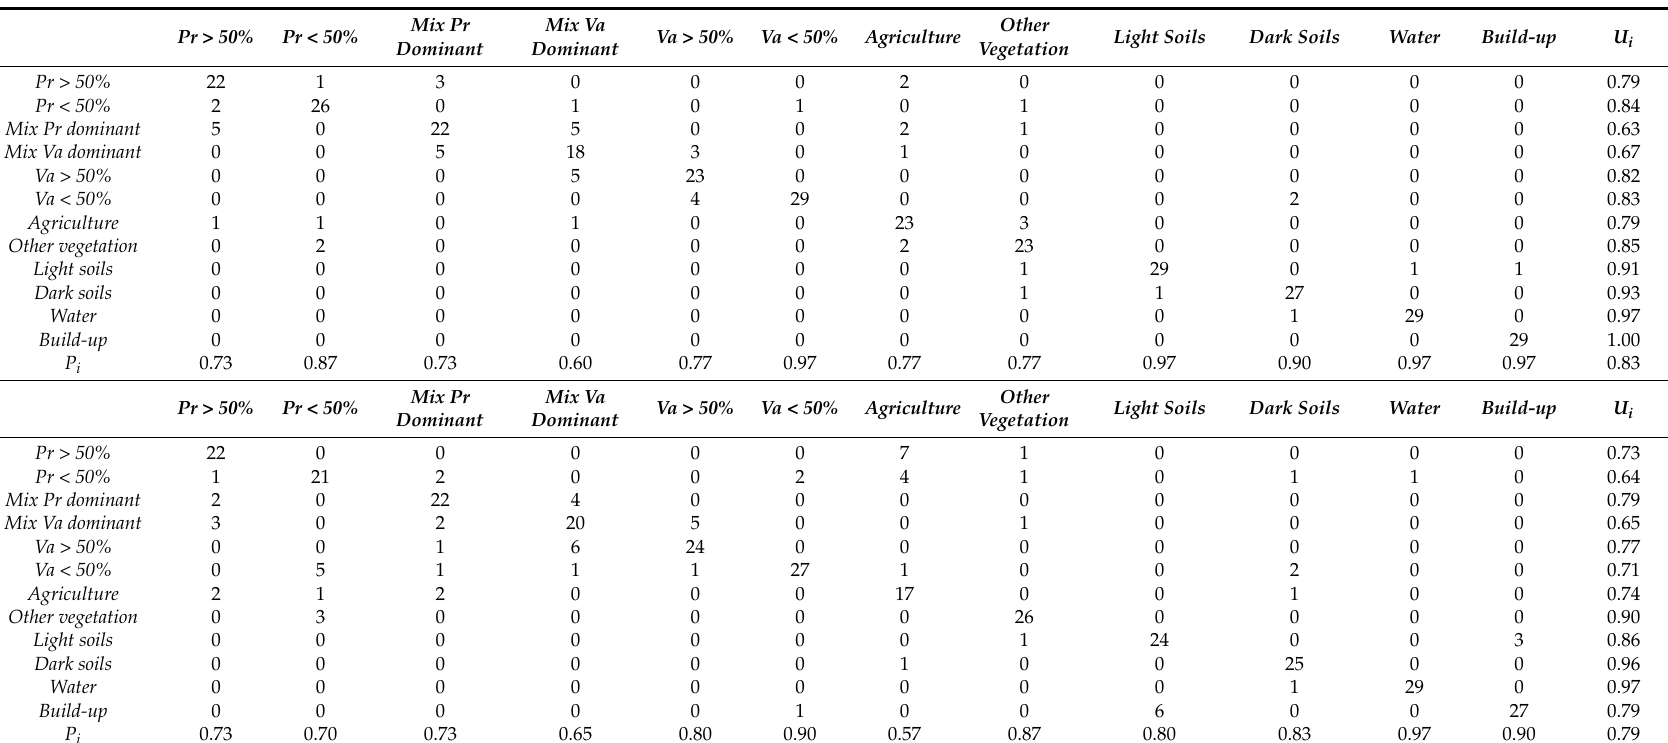
Table A1. Confusion matrices of 12-class OOB Pléiades ( top ) and Sentinel-2 ( bottom )